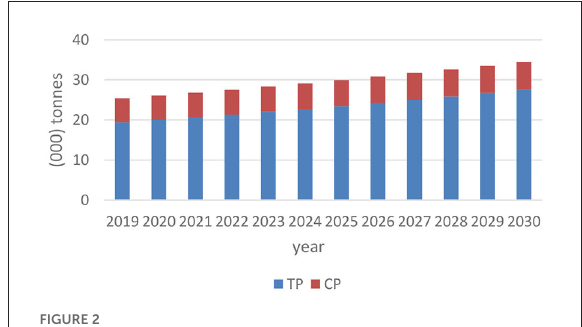
FIGURE2 Haitian pork supply in baseline (a) TP is acronym for traditional pig and CP is an acronym for commercial pig.